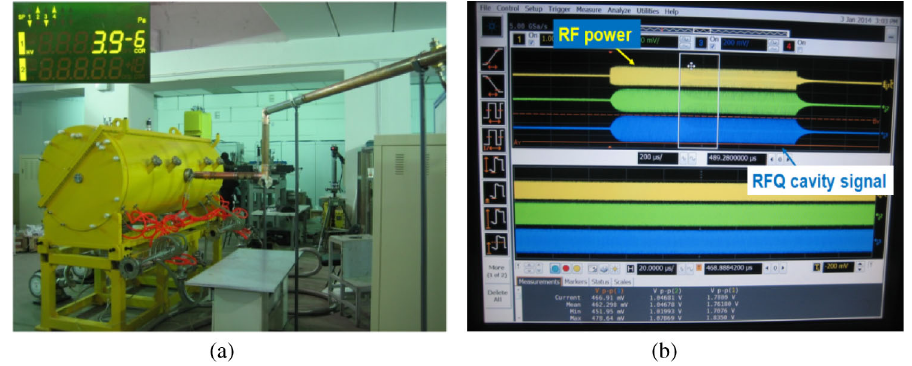
FIG. 21. High-power testing of